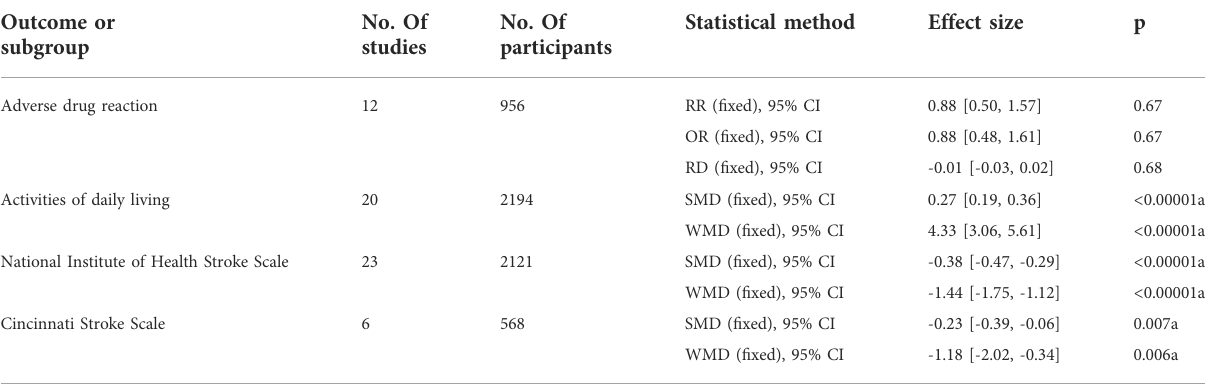
TABLE 5 Summary of the